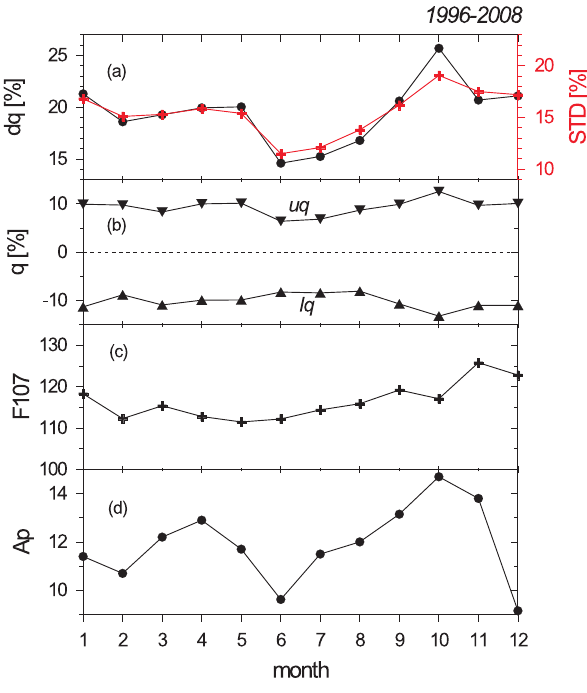
Fig. 9. Seasonal variation of (a) the quartile difference dq (black) and the standard deviation STD (red) as well as (b) the upper and lower quartiles (uq and lq) basing on hourly AI values. The corre- sponding variations of the solar and geomagnetic activity are shown in (c) and (d) . All data were derived for the period between 1996 and